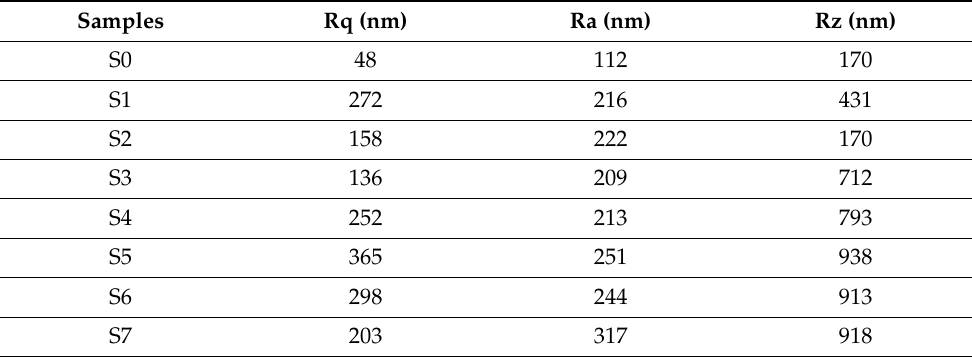
Table 4. Values of the root mean square roughness (Rq), the average roughness (Ra), and 10-point average roughness (Rz) of the